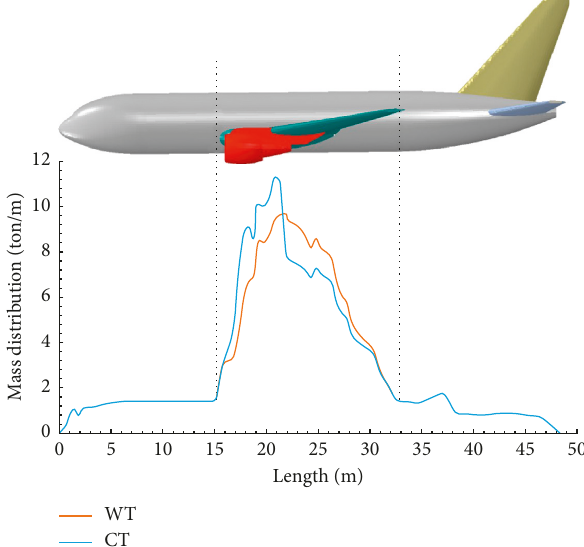
Figure 2: Longitudinal mass distribution of Boeing 767-200ER.